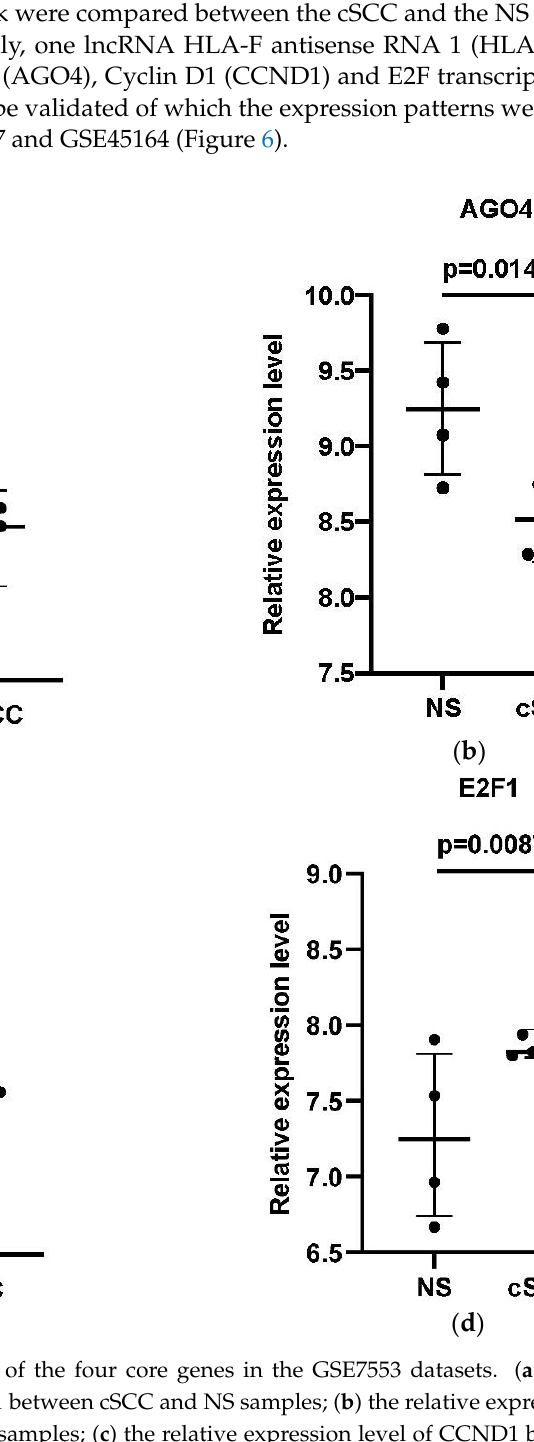
Figure 5. The hub-genes associated with the ceRNA network in a cSCC. MRNAs, miRNAs and lncRNAs are indicated by the circle in green, rectangle in red and triangle in blue, respectively.